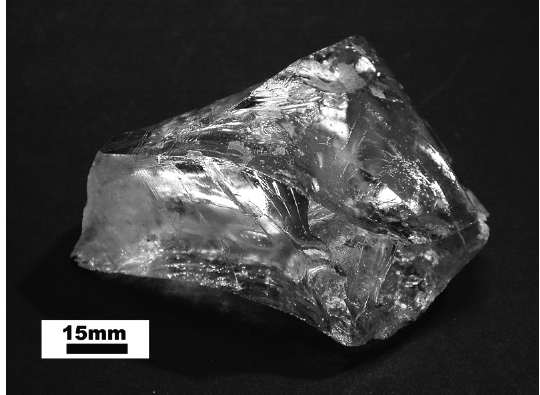
Figure 7: Part of a Roman glass ingot from les Embiez shipwreck, Côte d’Azur, still very fresh after 18 centuries spent in sea water [8]. This glass was likely made near Alexandria where the existence of natural ores of sodium carbonate gave a definite competitive advantage to local glass makers [9]. These exported ingots as well as finished products throughout the whole Mediterranean area, and even in Western Europe, where glass was extensively recycled, remelted and blown again, but not produced from raw materials before the third part of the first millennium